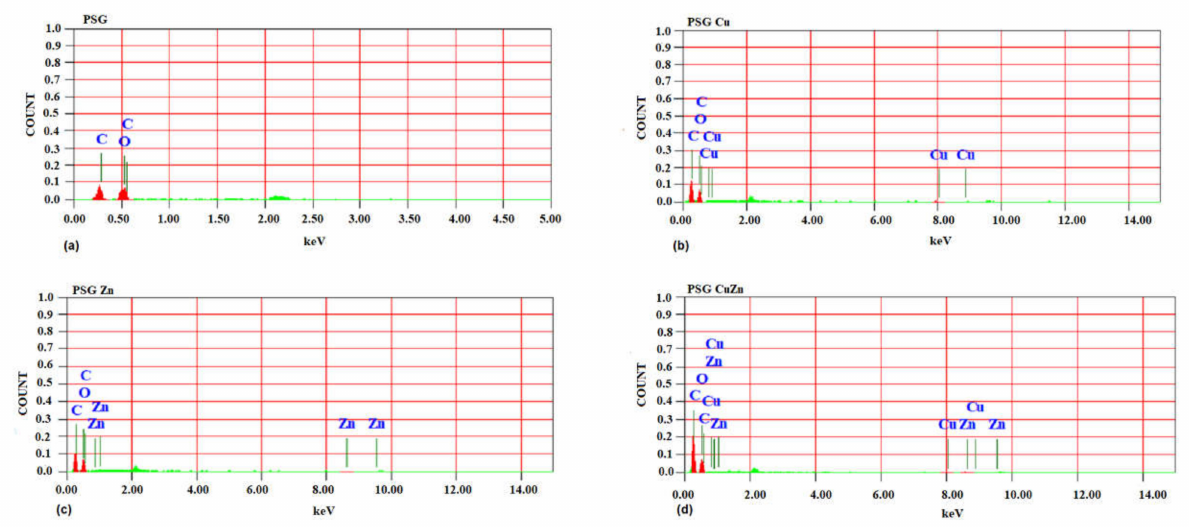
Figure 2. SEM-energy dispersive X-ray spectra of ( a ) PSG, ( b ) PSG-Cu, ( c ) PSG-Zn, and ( d ) PSG-CuZn films analyzing the elemental composition of developed polymer composite